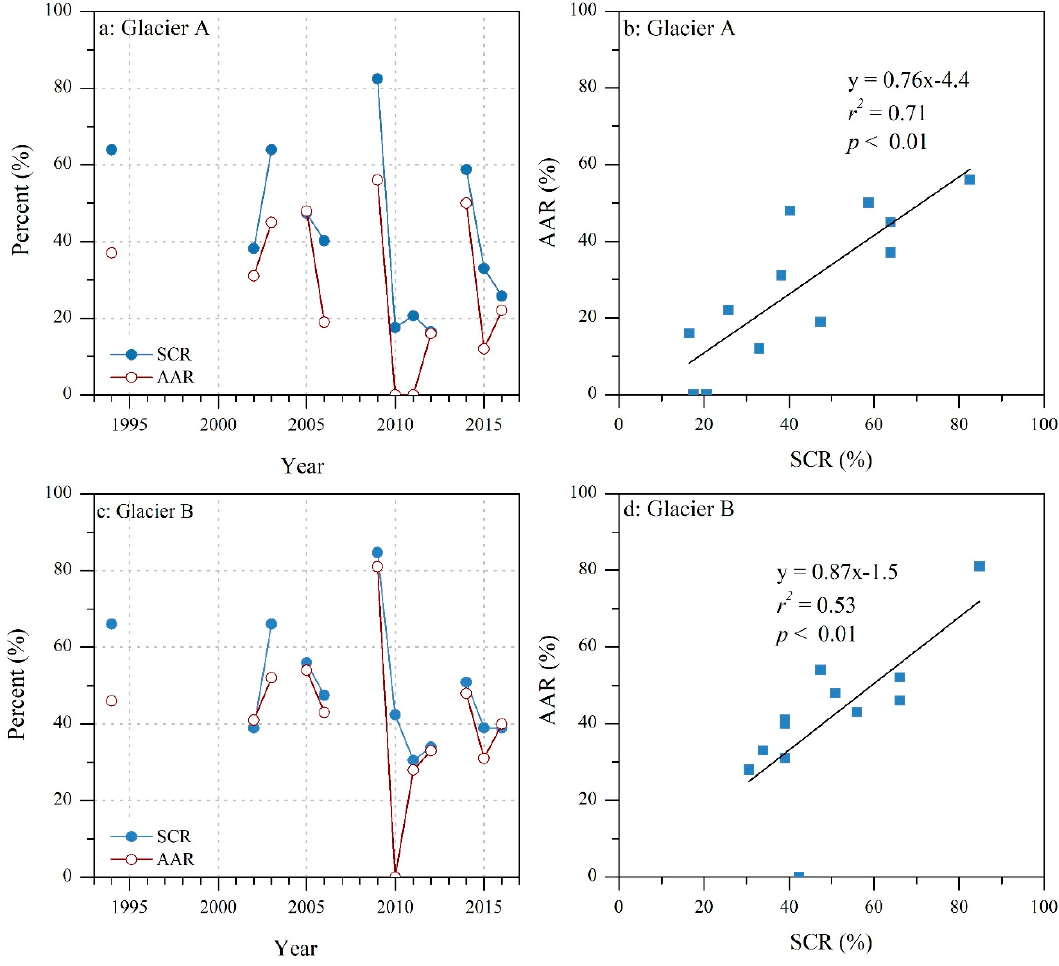
Figure 4. Snow-covered ratio (SCR) obtained from remote sensing compared to the accumulation area ratio (AAR) observed from field measurements of glacier A ( a , b ) and glacier B ( c , d ).